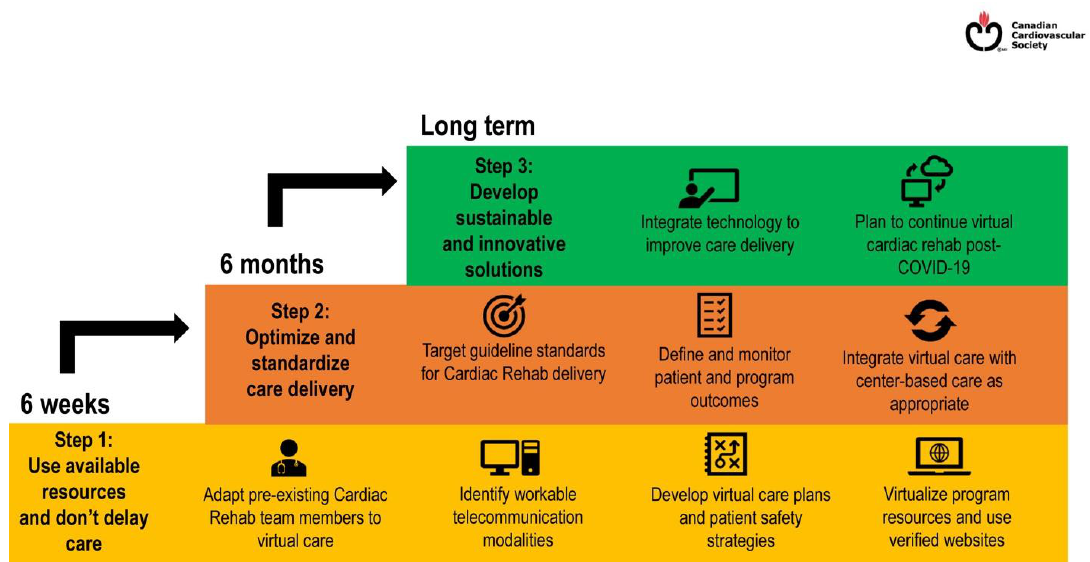
Figure 2. Steps of Virtual Cardiac Delivery (Cardiac Rehabilitation During the COVID-19 Era: Guidance on Implementing Virtual Care. Canadian Journal of Cardiology. 2020/08/01/ 2020; 36(8): 1317 – 132).